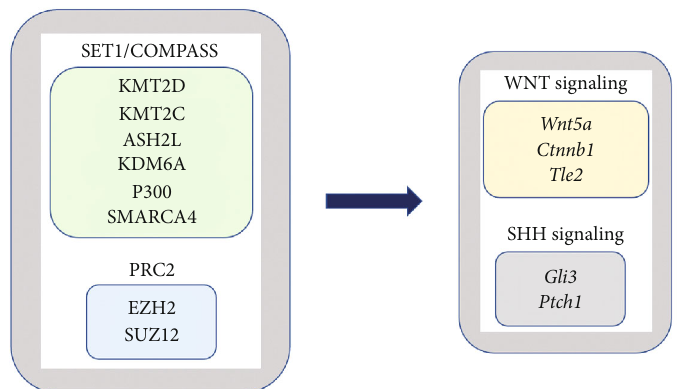
Figure 6: KMT2D and KDM6A form functional interactions with other components of the SET1/COMPASS complex and the PRC2 to control the expression of downstream targets of the WNT and SHH signaling pathways.